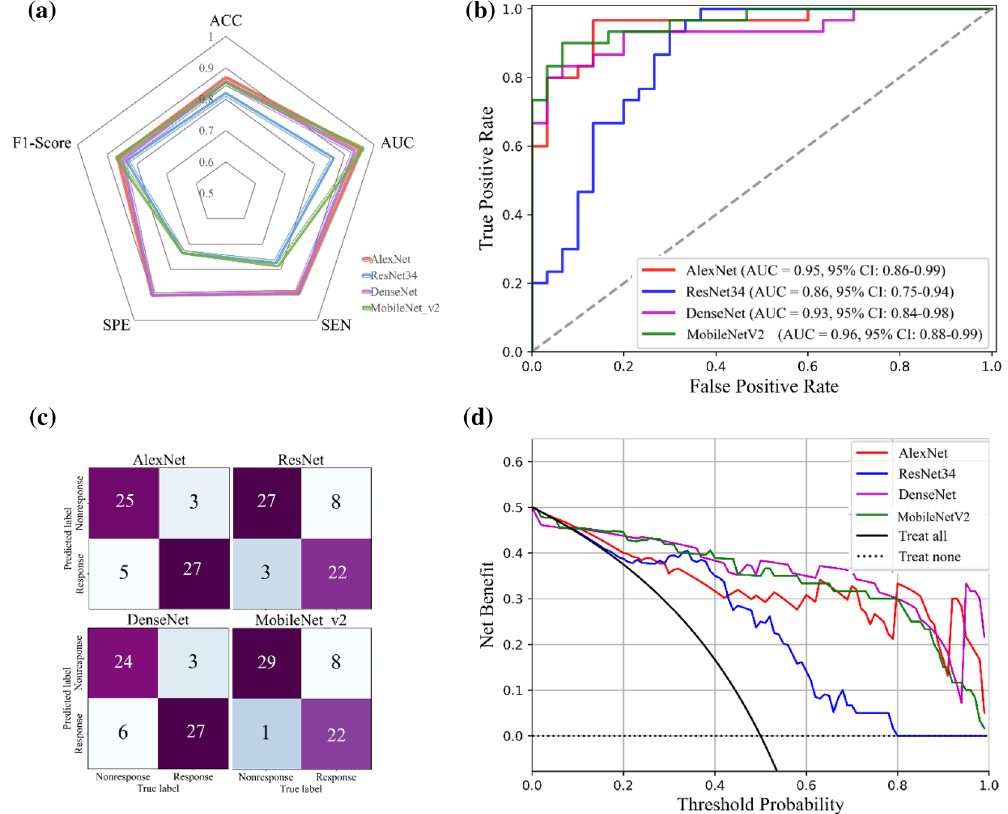
Figure 5. Performance of four counterparts with different backbone networks for feature extraction. ( a ) Statistical results; ( b ) The ROC curve; ( c ) The confusion matrix; ( d ) The DCA